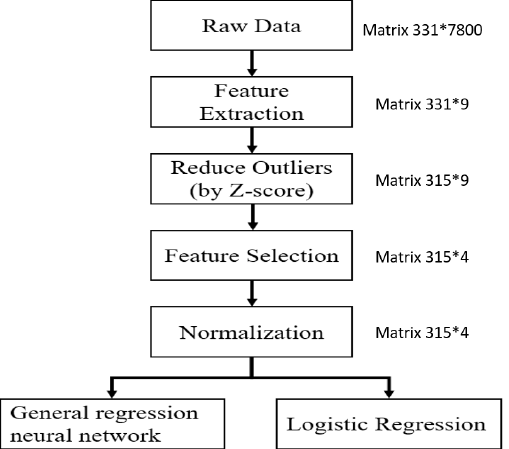
Figure 7. Flow chart of diagnosis based on feature extraction followed by the GA–GRNN and LR to create a RUL model of a WHRA.